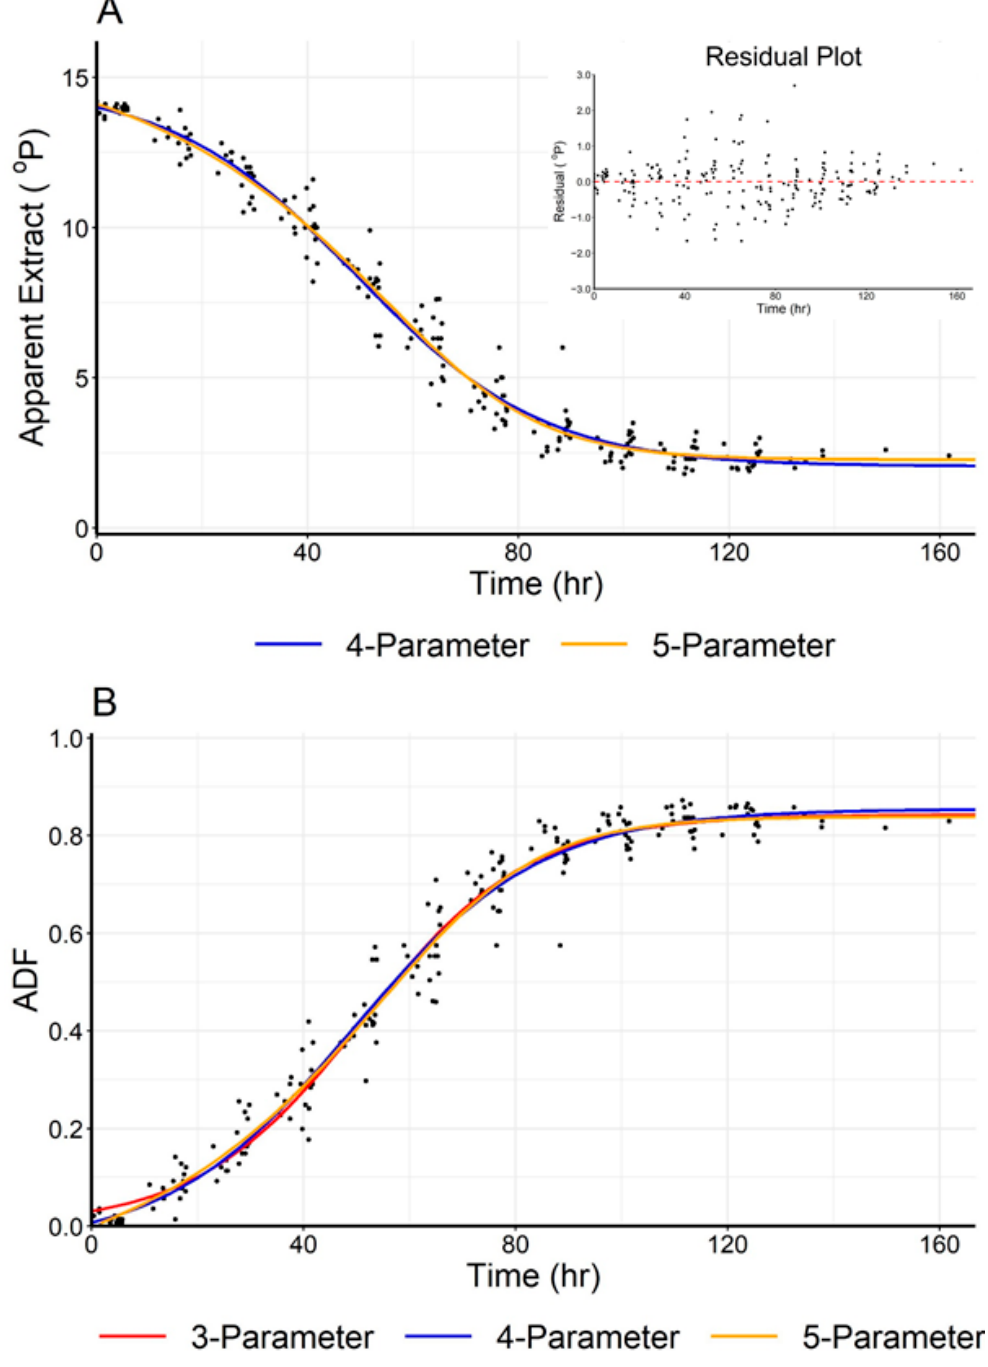
Figure 3. ( A ) A visual comparison of the four- and five-parameter models (Equations (1) and (2)) showing the dependence of Apparent Extract with time for fermentation five (Australian lager). The red line is the five-parameter model while the blue line indicates the four-parameter model. The insert shows the heteroscedasticity of the data based on the four-parameter logistic fit. ( B ) A comparison of the change in the ADF t as predicted by the three- (i.e., ADF ), four- and five-parameter models. ADF was calculated by assuming the OE was 14.1 ◦ P to provide a visual comparison of all three